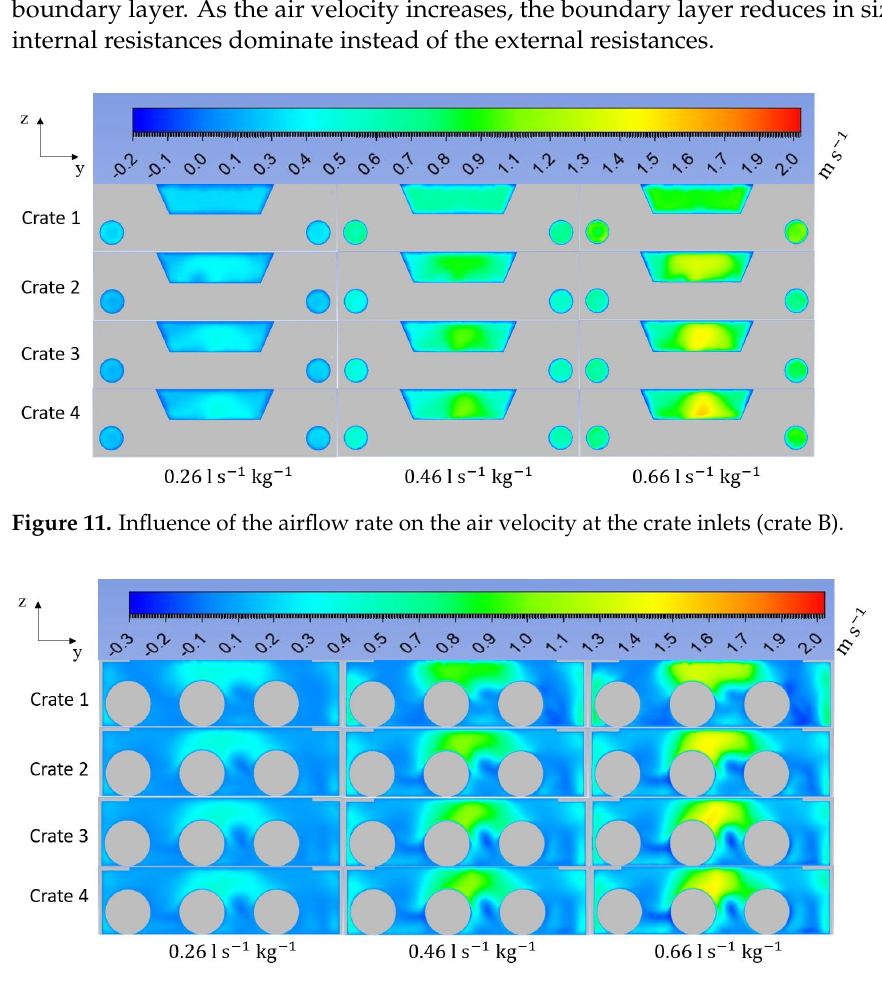
Figure 12. Influence of the airflow rate on the air velocity field within the crates (crate B).